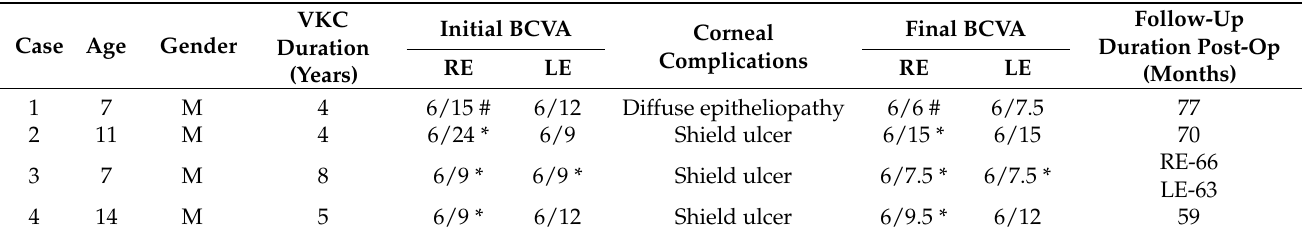
Table 1. Shows patient demographics, pre- and postoperative visual acuity, corneal complications, and follow-up